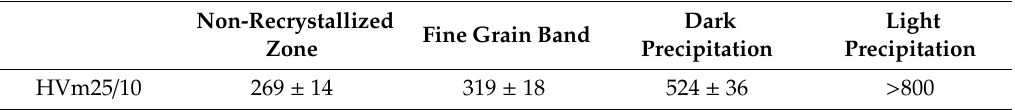
Table 2. Micro-hardness of di ff erent phases in annealed Inconel